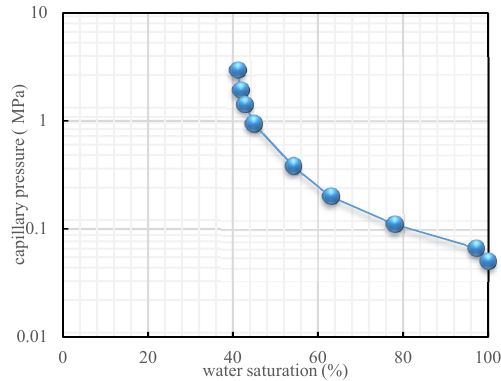
Figure 4. Curve of capillary pressure versus water saturation.